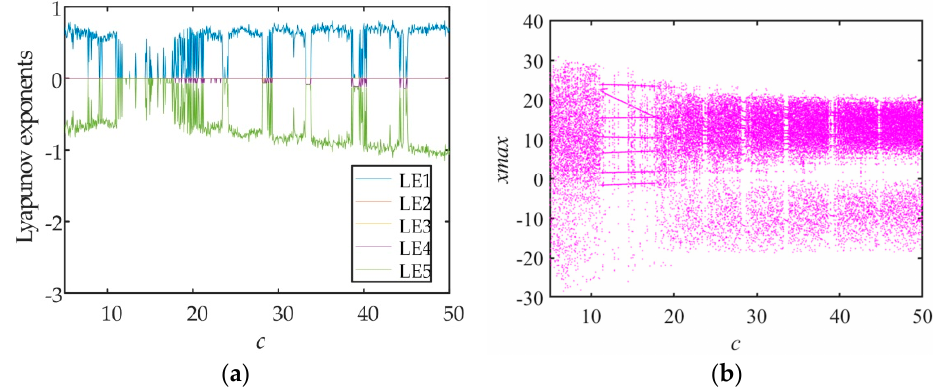
Figure 7. Lyapunov exponent spectrum and bifurcation diagram with parameter c , ( a ) Lyapunov exponent spectrum, ( b ) bifurcation diagram.